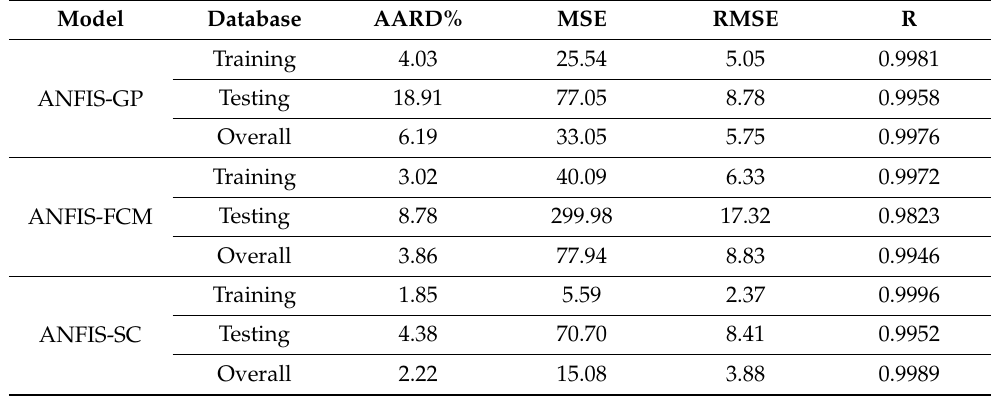
Table 3. Performance analysis of the selected ANFIS models by four statistical indexes.